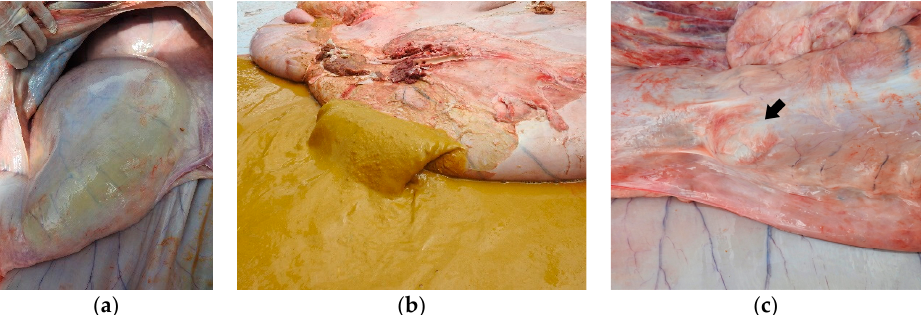
Figure 3. Necropsy findings showing proximal vagal indigestion in Buffalo 1: ( a ) dilation of the rumen and reticulum (I and II); reductions in the size and content of the omasum and abomasum (III and IV); ( b ) foamy and olive-green ruminal contents.